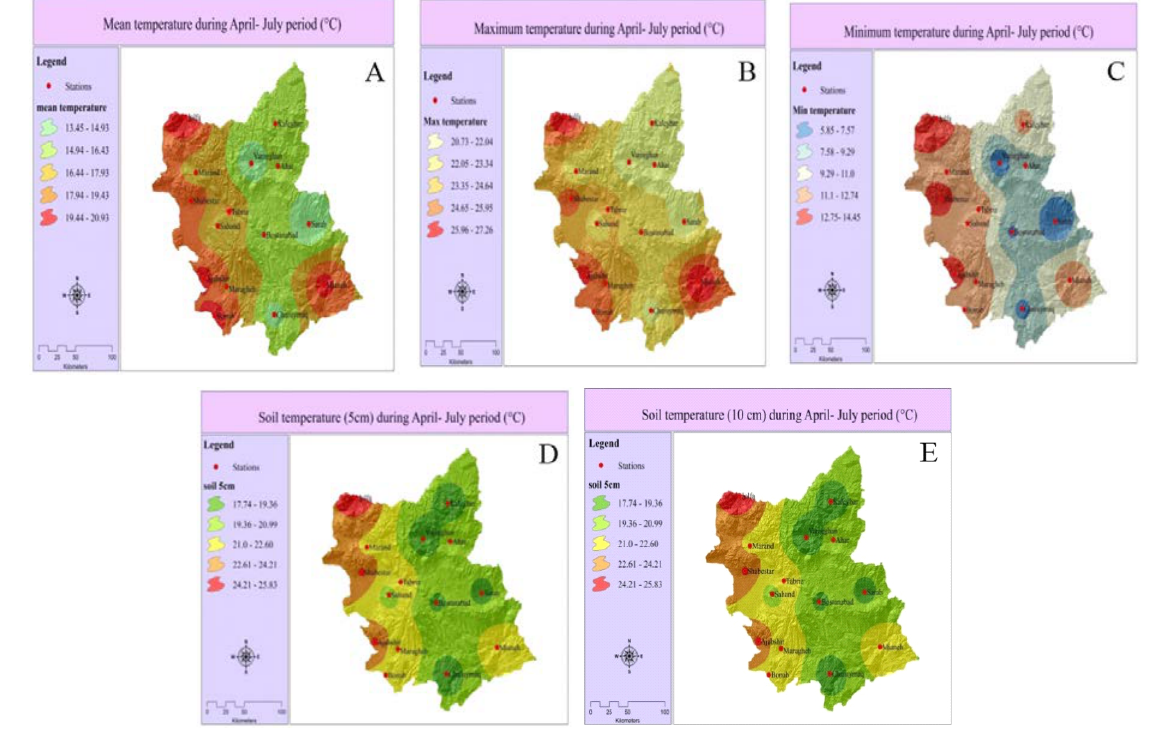
Fig. 2: Maps of air and soil temperature during April-July: A) Map of Mean temperature B) Map of maximum temperature C) Map of minimum temperature D) Map of soil temperature (5cm) E) Map of soil temperature (10